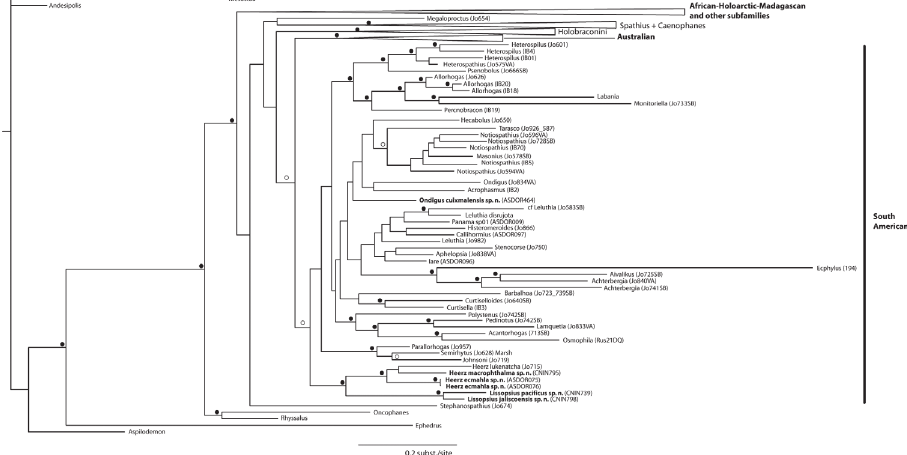
Figure 1. Bayesian phylogram showing the phylogenetic placement of the taxa described in this study within the Doryctinae. Black circles near branches represent posterior probabilities ≥ 0.95; blank circles represent posterior probabilities between 0.90 and 0.94. Names of the major clades are according to Zaldívar-Riverón et al.